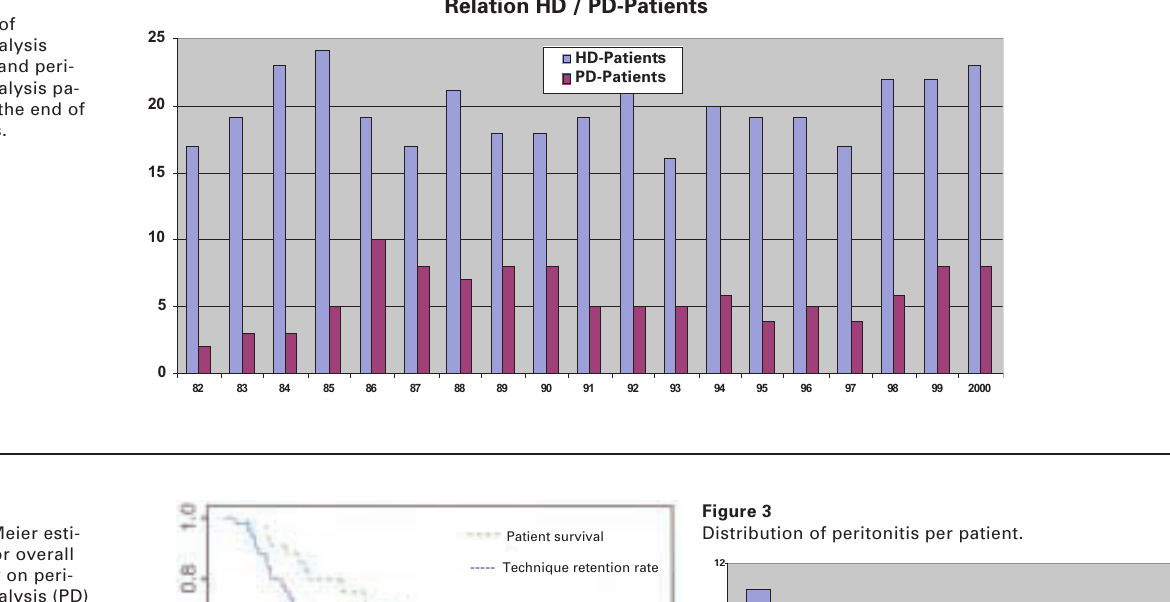
haemodialysis patients and peri- toneal dialysis pa- tients at the end of the years.